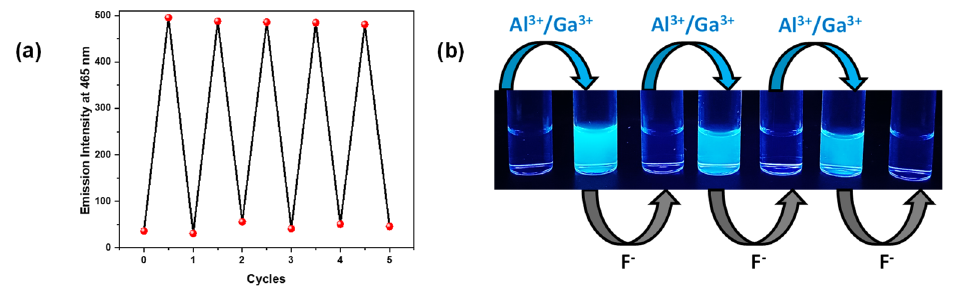
Figure 8. ( a ) Reversibility cycles for L1 (c, 20 µ M) upon subsequent addition of Al 3+ ion (as Al(NO 3 ) 3 , 2.5 equiv.) and F − ion (as NaF, 2.5 equiv.) in EtOH. ( b ) Reversibility cycles for L1 using Al 3+ ion (as Al(NO 3 ) 3 )/Ga 3+ ion (as GaCl 3 ) and F − ion (as NaF) under the UV light.